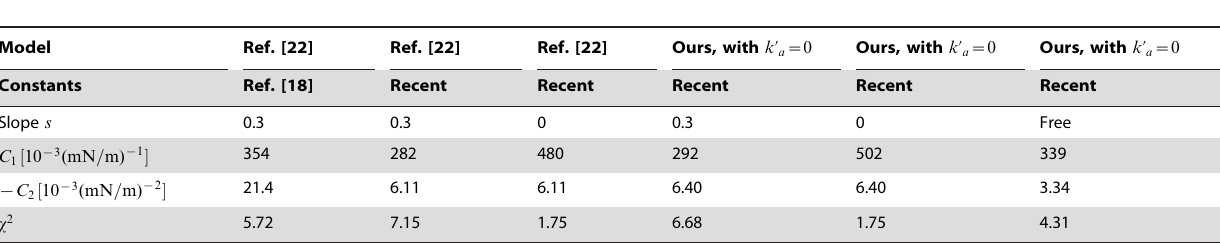
Table 2. Values of C 1 and C 2 obtained from the model of Ref. [22] and from our model with k ’ a ~ 0 .